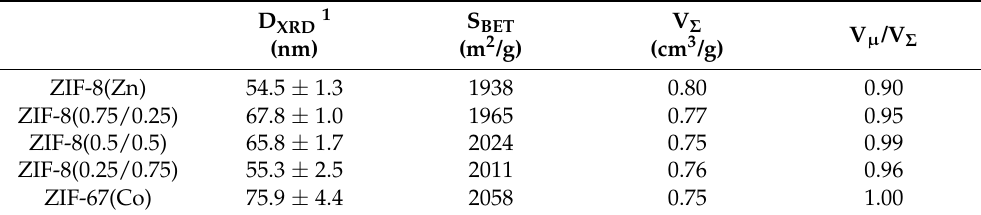
Table 3. Textural properties of ZIF samples with different crystal size.